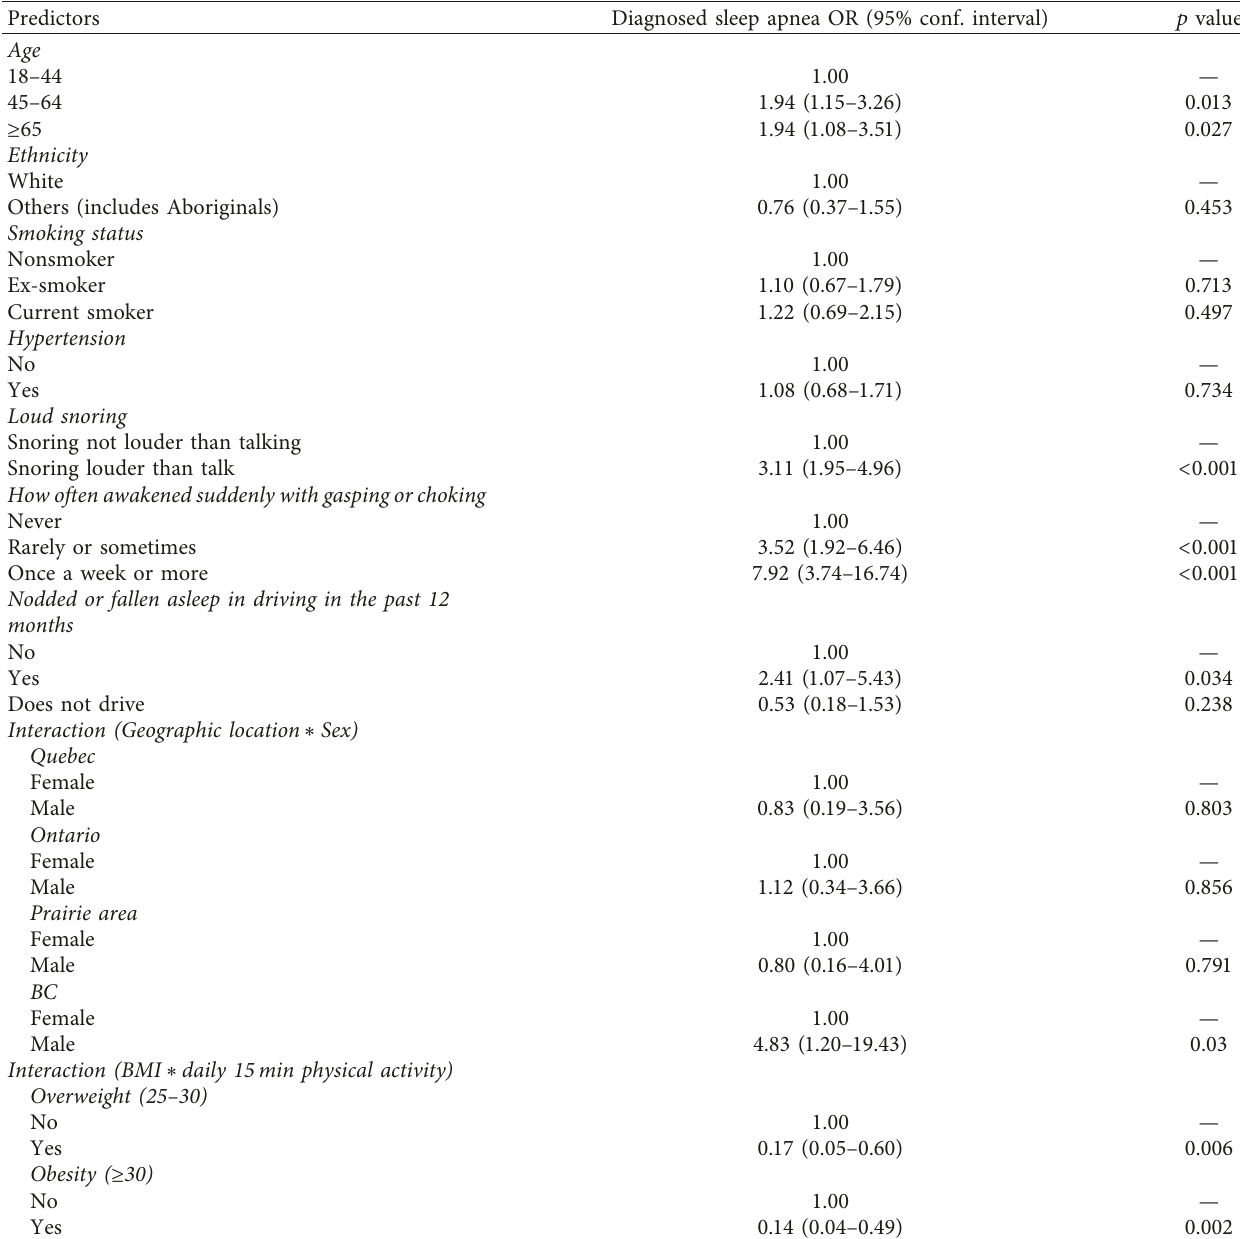
Table 2: Multivariate logistic regression of the association between sleep apnea and independent variables of